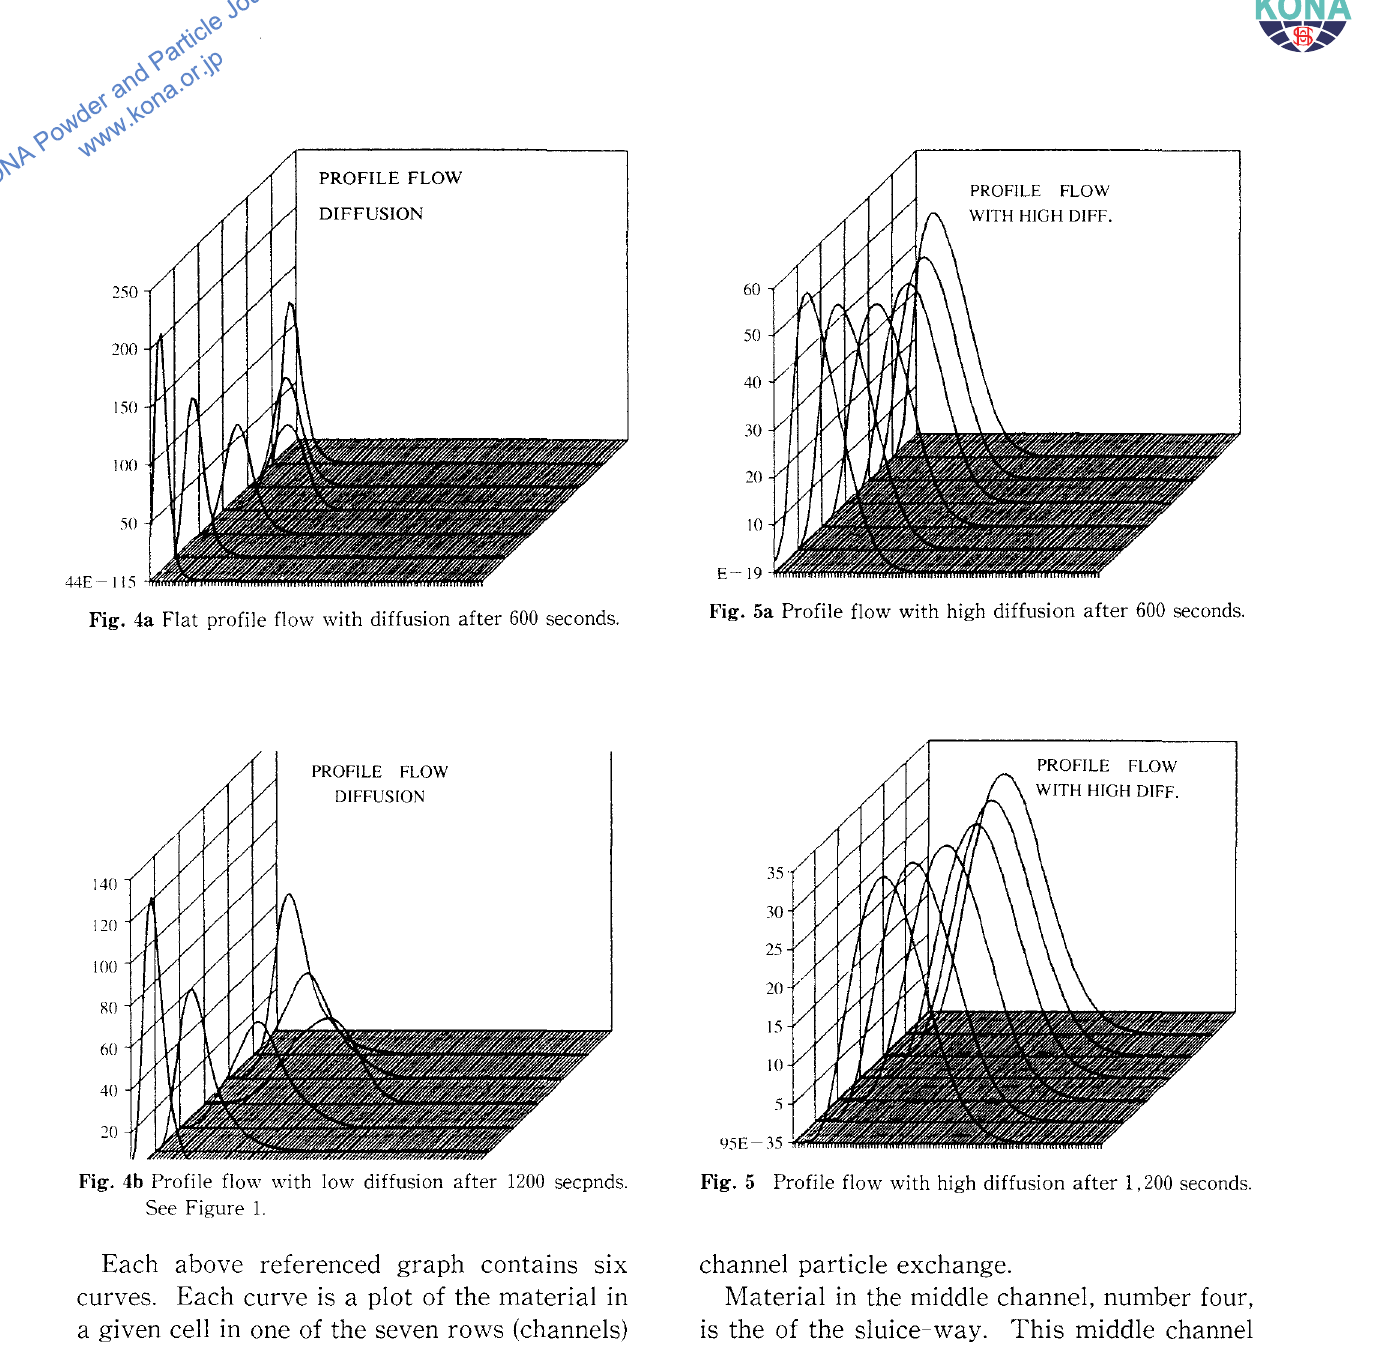
Fig. 5 Profile flow with high diffusion after 1. 200